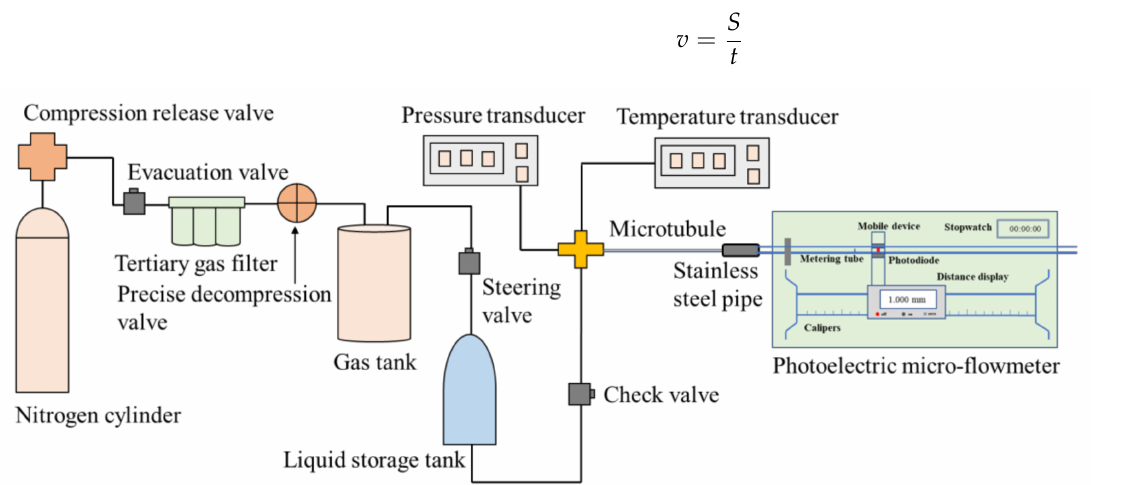
Figure 2. Schematic diagram of the microtubule flow experiment. The experimental equipment comprised a nitrogen cylinder to provide driving gas, a tertiary gas filter to filtrate impurities in gas, a gas tank to store the filtered gas, a liquid storage tank to store the aqueous solution of SiO 2 /P(MBAAm -co- AM) polymeric nanoparticles, a pressure transducer to determine the driving pressure, a temperature transducer to determine the ambient temperature, and a photoelectric micro-flowmeter to measure the fluid velocity in the microtubule.